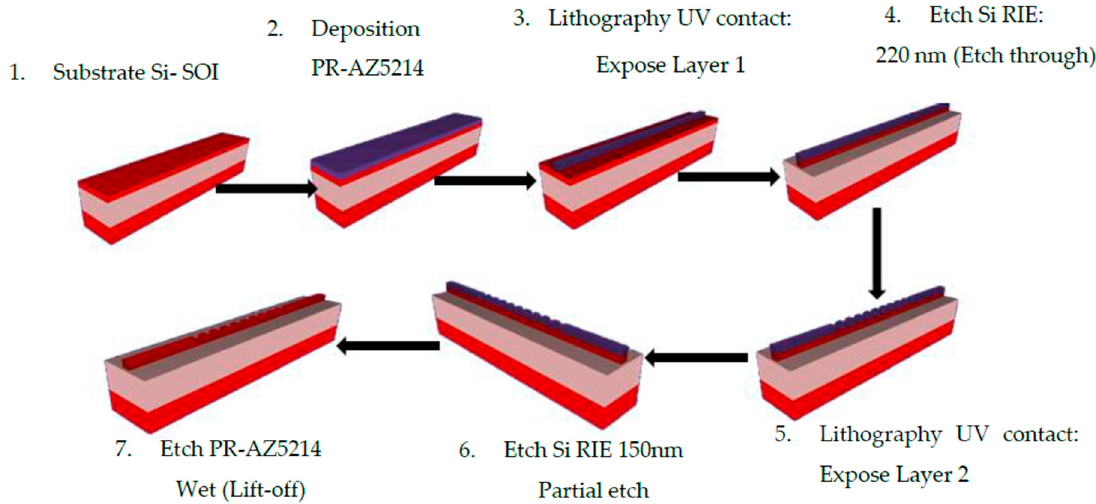
Figure 9. Fabrication process flow steps of the SOI grating coupler simulated using the Intellisense simulation package.